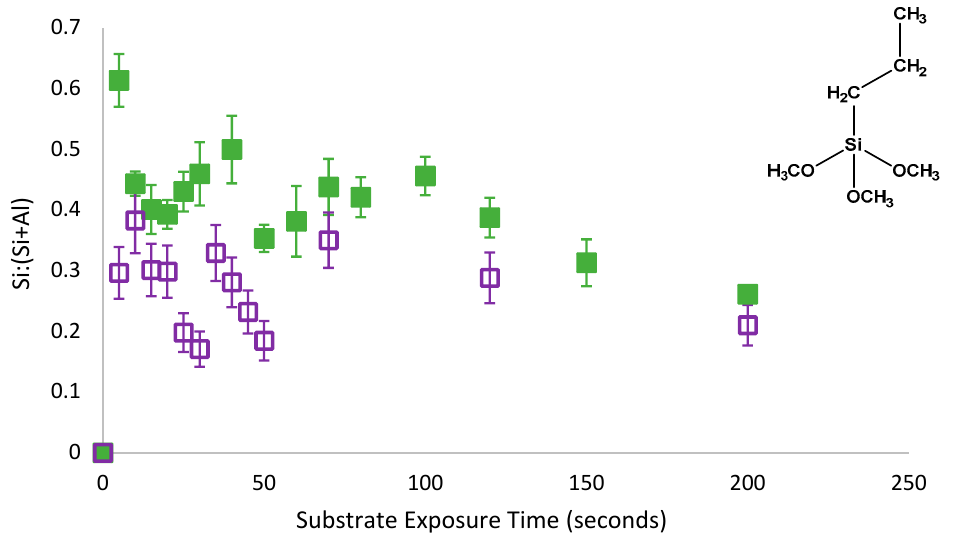
Figure 5. Oscillatory adsorption of 1% PTMS in 1:1 EtOH:H 2 O solvent at pH3 on aluminium foil substrate measured using XPS. Upon removal from solution, films were either dried with N 2 (solid green squares) [8] or rinsed with pH3 CH 3 COOH (open purple squares) prior to drying and curing.